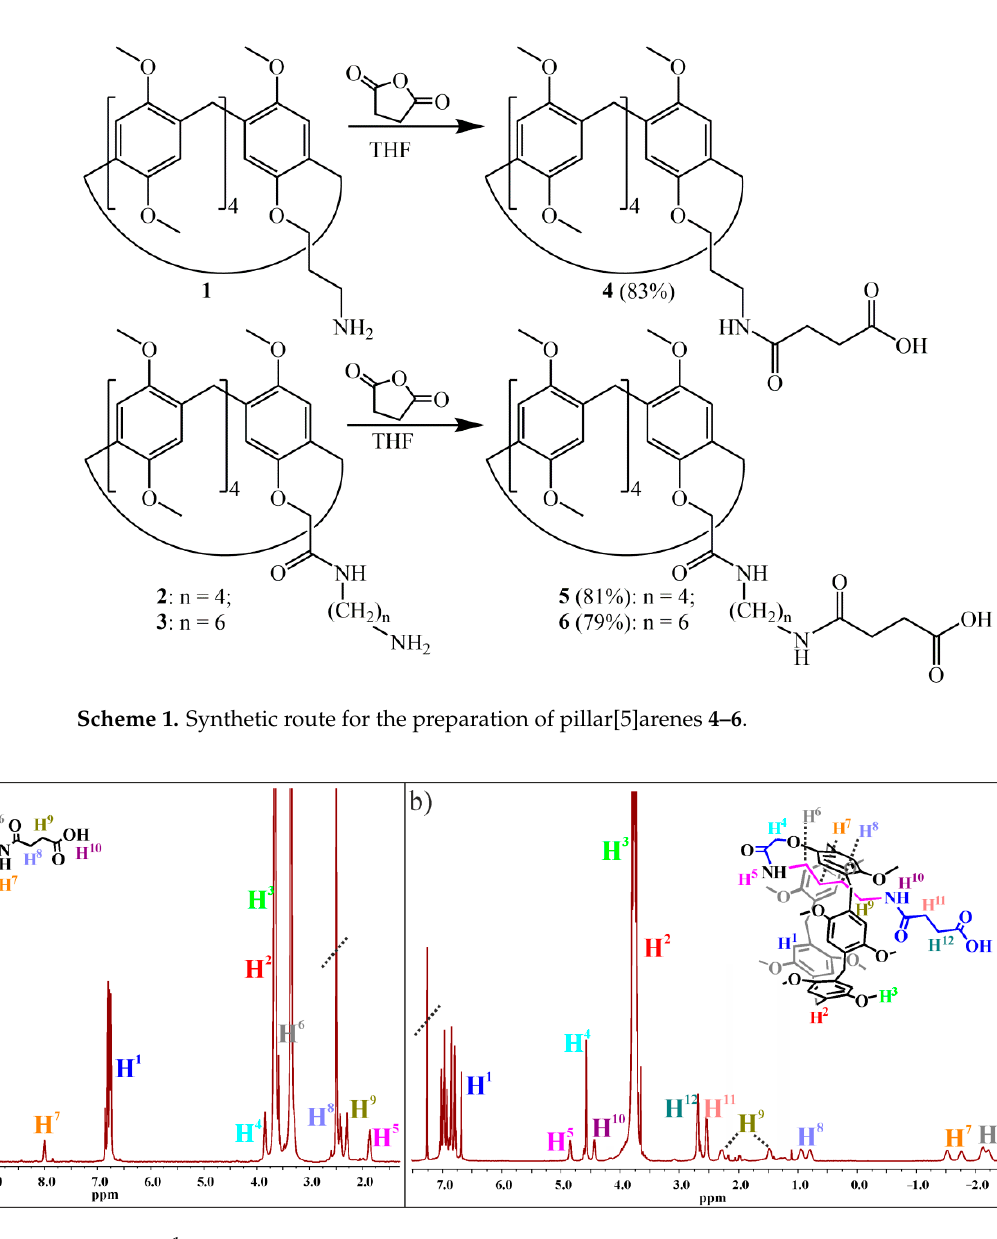
Figure 1. 1 H NMR spectra of: ( a ) the macrocycle 4 (DMSO- d 6 , 400 MHz, 293 K); ( b ) the macrocycle 5 (CDCl 3 , 400 MHz, 298 K).